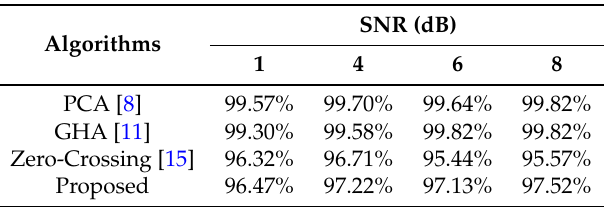
Table 7. The CSRs of the various feature extraction algorithms for different SNR levels. The spike source data are obtained by the simulator in [18].